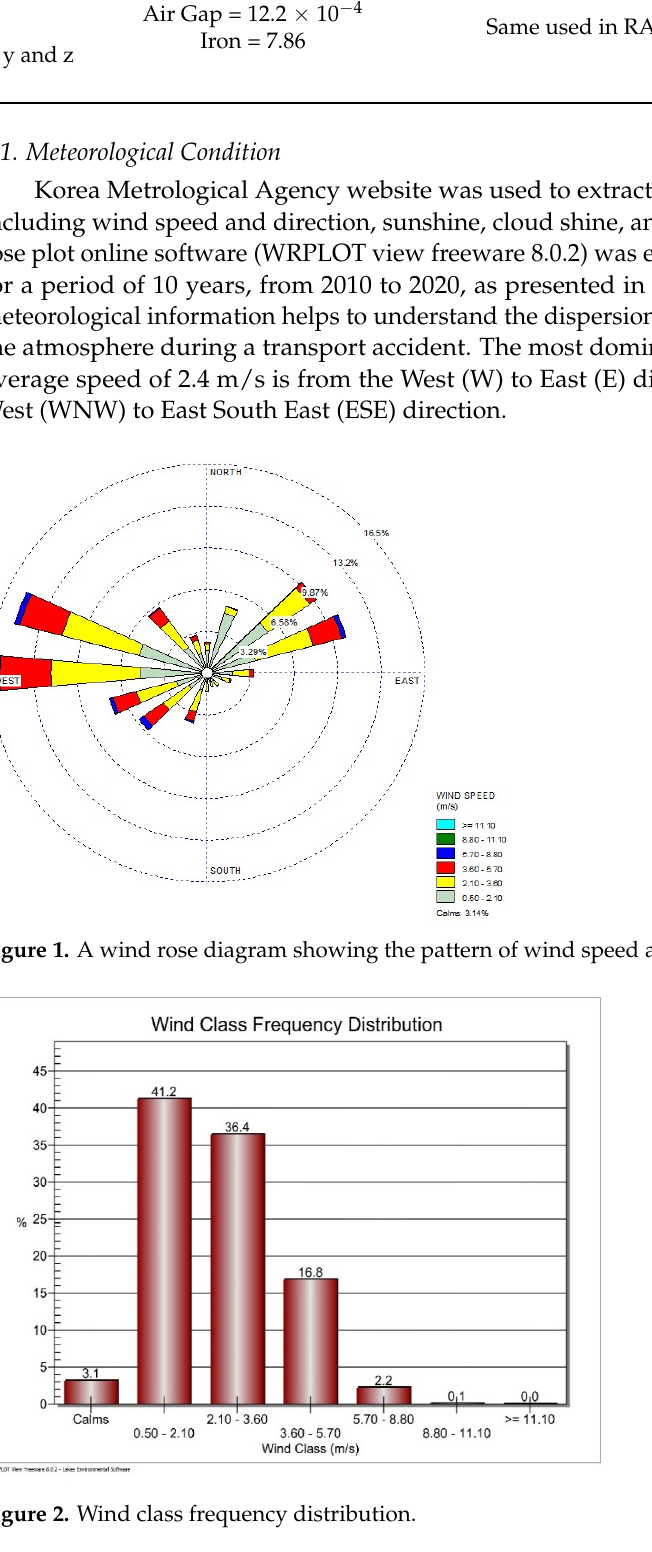
Figure 2. Wind class frequency distribution.